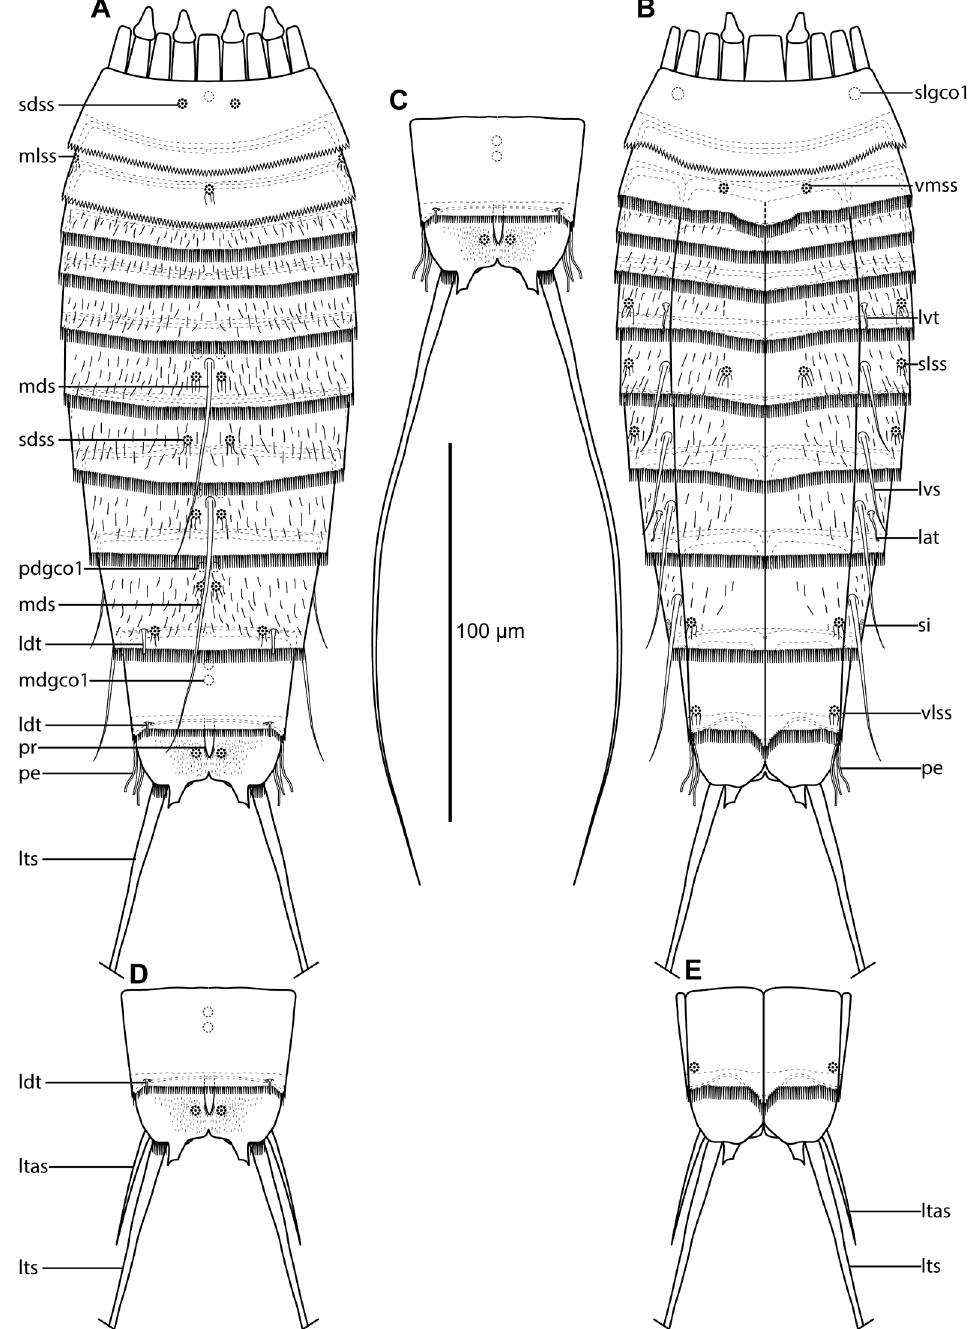
Fig. 10. Line art illustrations of Echinoderes hviidarum sp. nov. A . ♂, dorsal view. B . ♂, ventral view. C . ♂, segments 10 to 11, with lateral terminal spines drawn in full length, dorsal view. D . ♀, segments 10 to 11, dorsal view. E . ♀, segments 10 to 11, ventral view. Abbreviations: lat = lateral accessory tube; ldt = laterodorsal tube; ltas = lateral terminal accessory spine; lts = lateral terminal spine; lvs = lateroventral spine; lvt = lateroventral tube; mdgco1 = middorsal glandular cell outlet type 1; mds = middorsal spine; mlss = midlateral sensory spot; pdgco1 = paradorsal glandular cell outlet type 1; pe = penile spines; pr = protuberance; sdss = subdorsal sensory spot; si = sieve plate; slgco1 = sublateral glandular cell outlet type 1; slss = sublateral sensory spot; vlss = ventrolateral sensory spot; vmss = ventromedial sensory